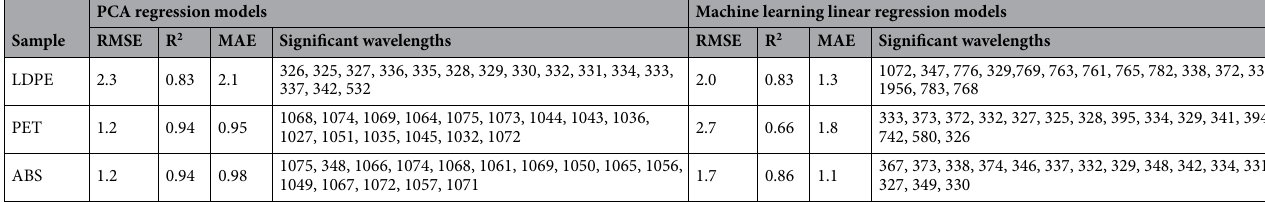
Table 1. RMSE, R2, and selected significant wavelengths generated from PCA regression models and machine learning linear models. Accuracy metrics for regression models were generated by testing the models on 30% of the test